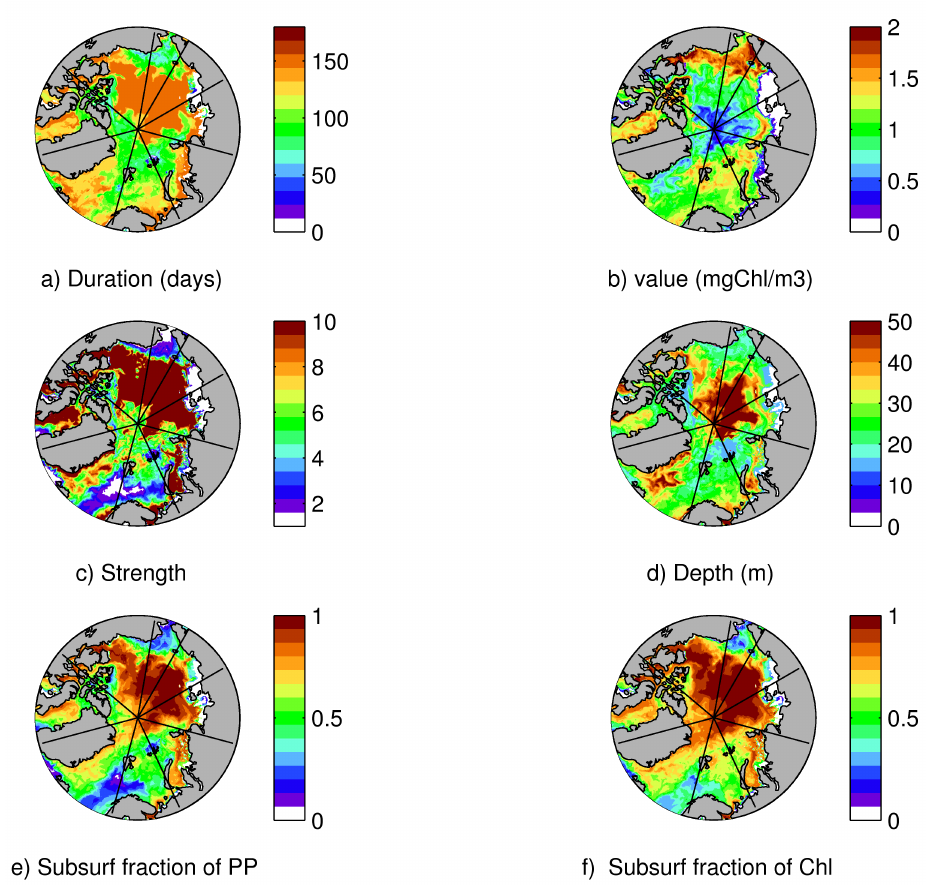
Fig. 9. Duration of the subsurface Chl- a maximum in days (a) , average value of the Chl- a maximum in mgChlm − 3 (b) , averaged strength (calculated as a ratio of subsurface maximum to the surface value), (c) , and averaged depth in m (d) ; contribution of the subsurface Chl- a maximum to water column integrated primary production (e) and Chl- a (f) . The contribution of the subsurface maximum to water column characteristics is calculated as a ratio of the integral value below the UML depth to the total water column integral